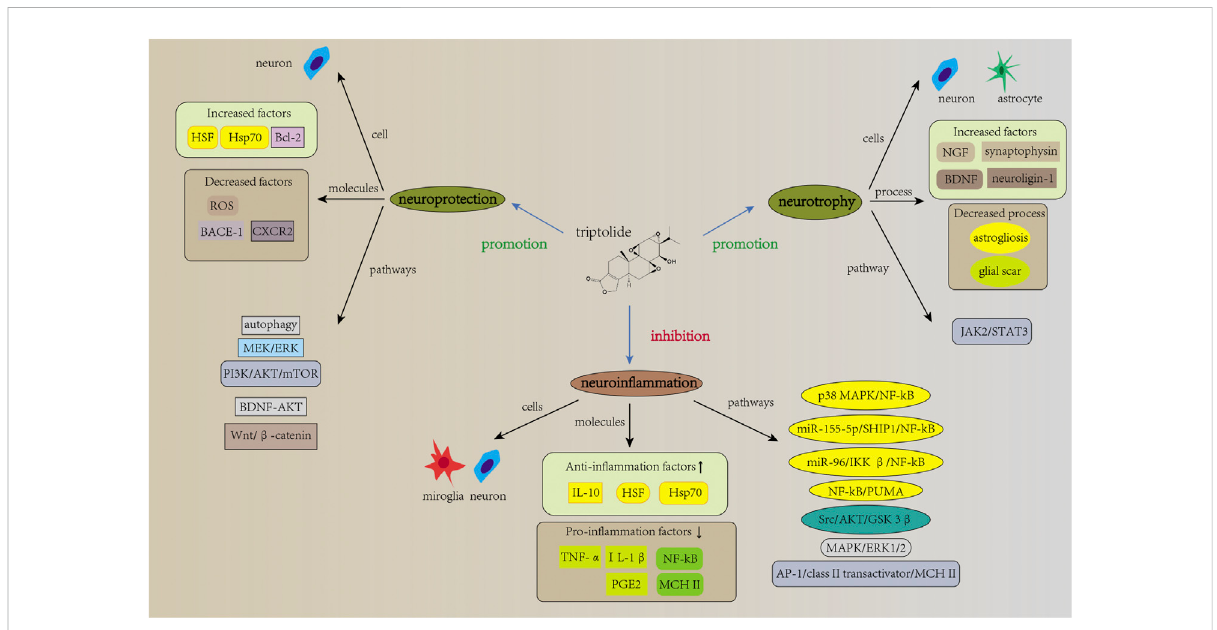
FIGURE 2 Mechanisms of action of triptolide in neurological diseases. The mechanisms of action of triptolide in neurological diseases involves neuroin fl ammation, neurotrophic effects, and other neuroprotective effects. It attenuates neuroin fl ammation and regulate in fl ammation levels in microglia and neuron, as evidenced by increased expression of anti-in fl ammatory factors and decreased expression of pro-in fl ammatory factors. Signalingpathwayssuchas NF-kBareinvolvedinthisregulation.Inaddition,currentstudieshavereportedneurotrophic effectsoftriptolidefor neurologicaldiseases.TriptolideincreasestheexpressionlevelsofNGF,synaptophysin,neuroligin-1,and BDNF mRNA,anditalsoinhibitsastrogliosis andexcessiveglialscar,whichisassociatedwiththeregulationofJAK2/STAT3signalingpathway.Furthermore,triptolidecanactdirectlyonneurons and thus exert neuroprotective effects by affecting other signaling pathways such as autophagy and